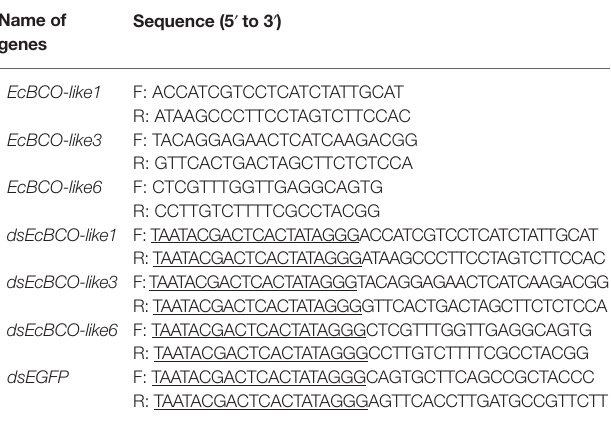
TABLE 2 | Information of primers used for dsRNA